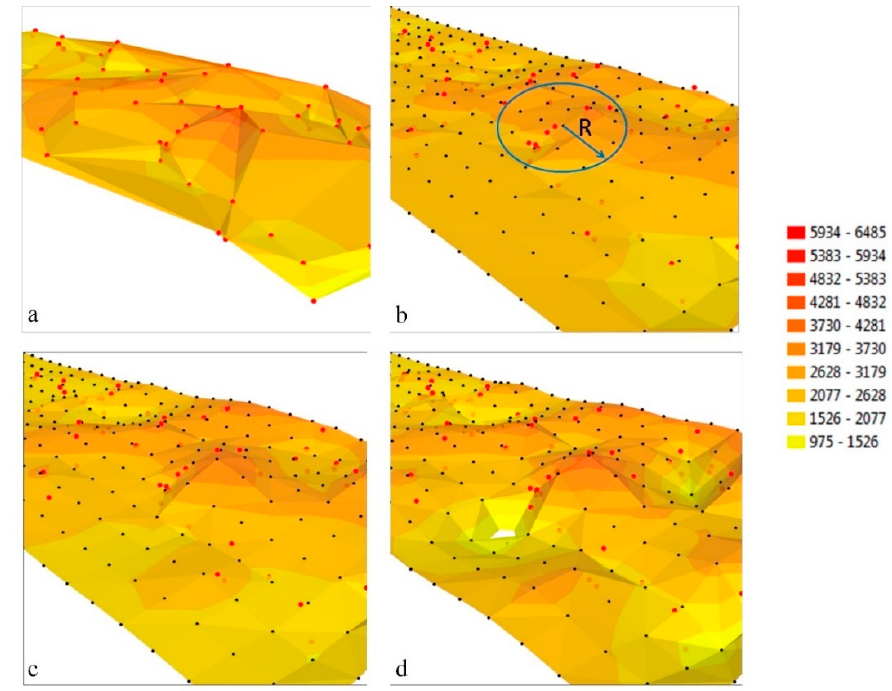
Figure 2. Comparison of TIN and GRID surfaces generated with various interpolation algorithms: ( a ) original TIN; ( b ) inverse distance to a power: 2; ( c ) Kriging: Linear; ( d ) radial basis function (RBF): Multilog. Source: own elaboration.